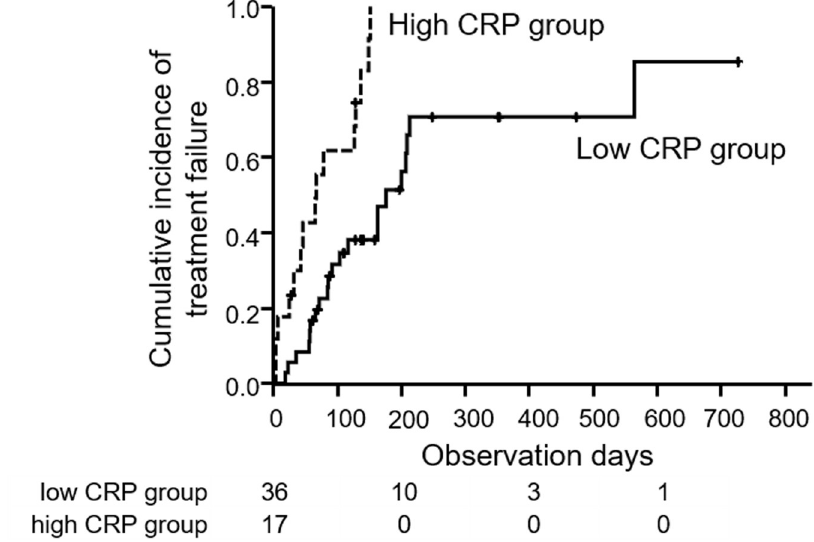
Fig 3. Time to treatment failure (TTF) in high and low CRP groups. Median TTFs in high CRP group (dotted line) and low CRP group (solid line) were 67 and 176 days, respectively (log-rank test; p < 0.001).